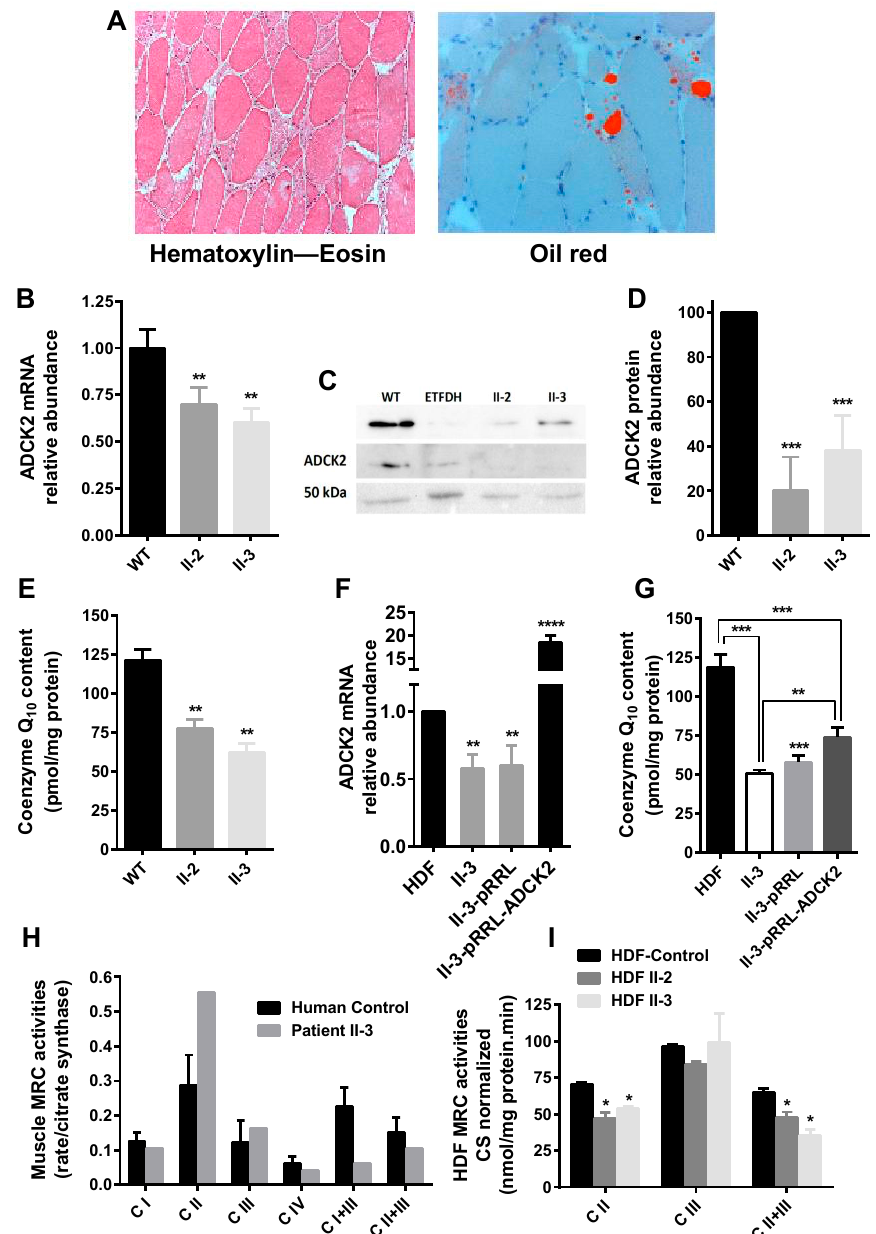
Figure 1. Laboratory findings in the index patient. ( A ) Histological findings in muscle of patient II-3: (left picture) some fiber atrophy and fibers containing numerous vacuoles were apparent with the haematoxylin–eosin stain ( × 10); (right picture) Gomori trichrome stain showing lipid droplets in some muscle fibers ( × 20). ( B ) Measurement of the amount of aarF domain-containing mitochondrial protein kinase 2 ( ADCK2) mRNA in cultured fibroblasts from II-3 and II-2 relative to controls. ( C ) Western blotting of ADCK2 in cultured fibroblasts from II-3 and II-2. ( D ) Quantification of the protein expression levels measured in (C). ( E ) Coenzyme Q (CoQ) content in dermal fibroblasts from patients II-3 and II-2 ( n = 5). Expression level of ADCK2 mRNA ( F ) and CoQ content ( G ) in patient fibroblasts transformed with the ADCK2 wild type (WT) allele ( n = 5). ( H ) Mitochondrial respiratory chain (MRC) activities in muscle biopsy of patient II-3 normalized to citrate synthase (CS). The complexes III and IV values shown are × 10 − 2 . ( I ) MRC activities in human dermal fibroblasts (HDF) from control, patient II-3, and his sister II-2. * p < 0.05, ** p ≤ 0.01, *** p ≤ 0.005 vs. control / WT, **** p < 0.001 vs. non-transformed / empty vector; n = 10. Data were analyzed using Student’s t test.